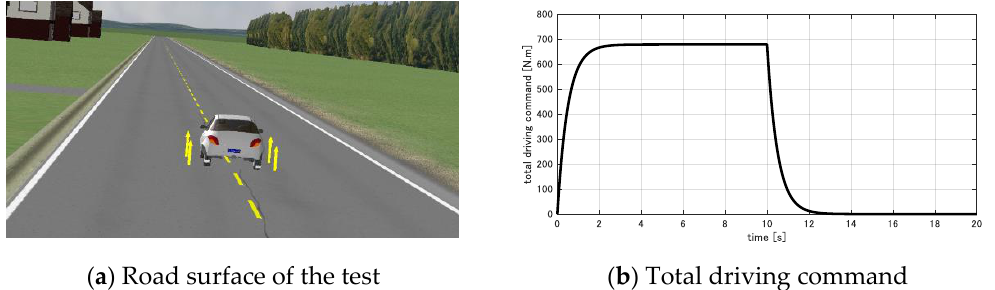
Figure 17. Simulation setting for evaluating wheel velocity control using DM-2.